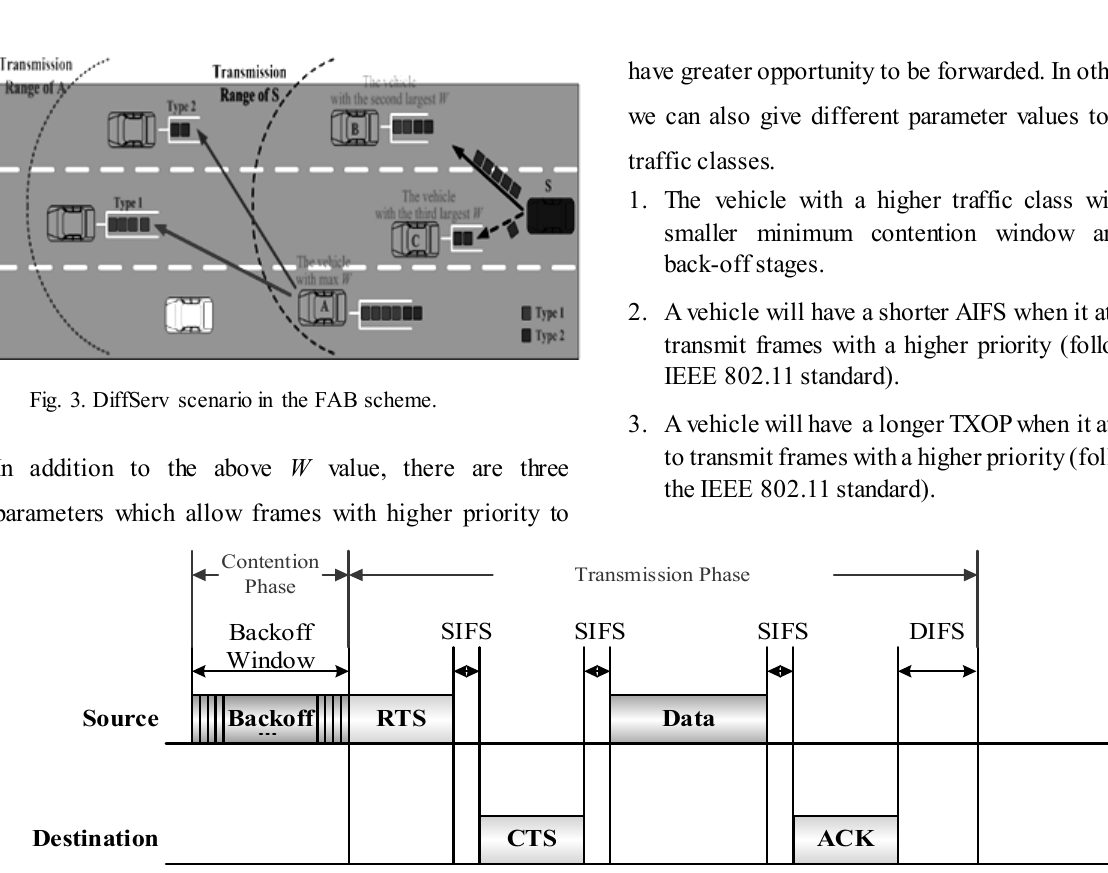
Fig. 4. The overhead in the contention phase and the transmission phase from Ref.